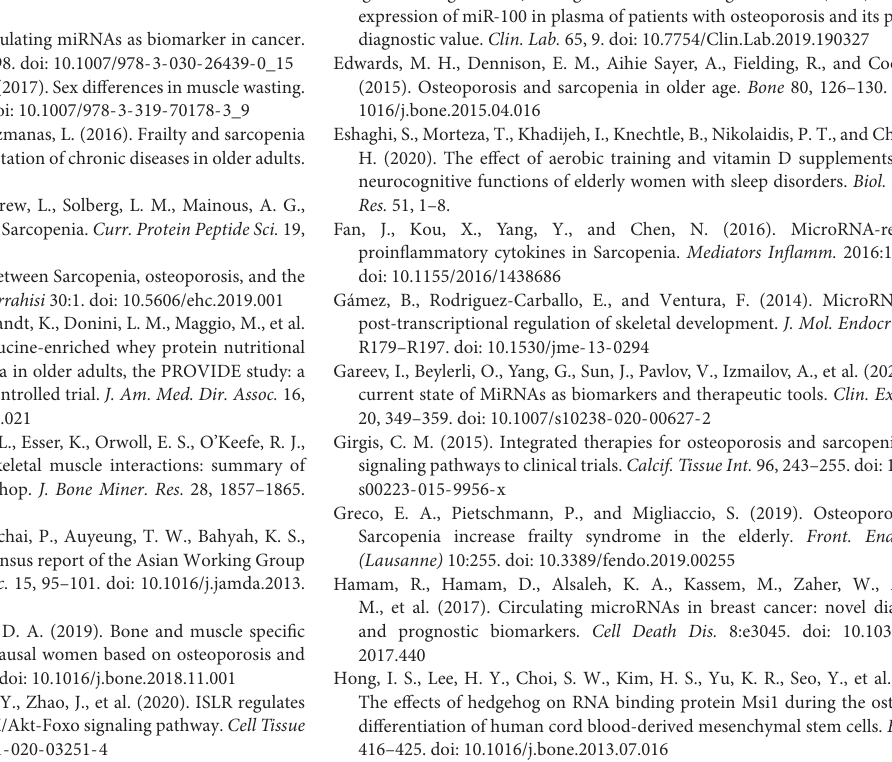
Supplementary Figure 1 | Fracture risk-associated circulating miR-23a-3p, miR-93-5p and miR-637 decrease in response to sarcopenia without diabetes in the elderly. The expression level of miRNAs were normalized using spike-in cel-miR-39; unpaired T -test was used for these data; *compared to non-sarcopenia of the elderly; * P < 0.05; n = 40. Supplementary Figure 2 | Correlation analysis between the lowest and highest quartile of the miR-23a-3p (A) , miR-93-5p (B) , miR-637 (C) , and ASM/Height 2 (kg/m 2 ), Handgrip strength (kg) and 4-m velocity (m/s). Pearson’s method was used for Correlation analyses; * P < 0.05 ; n =